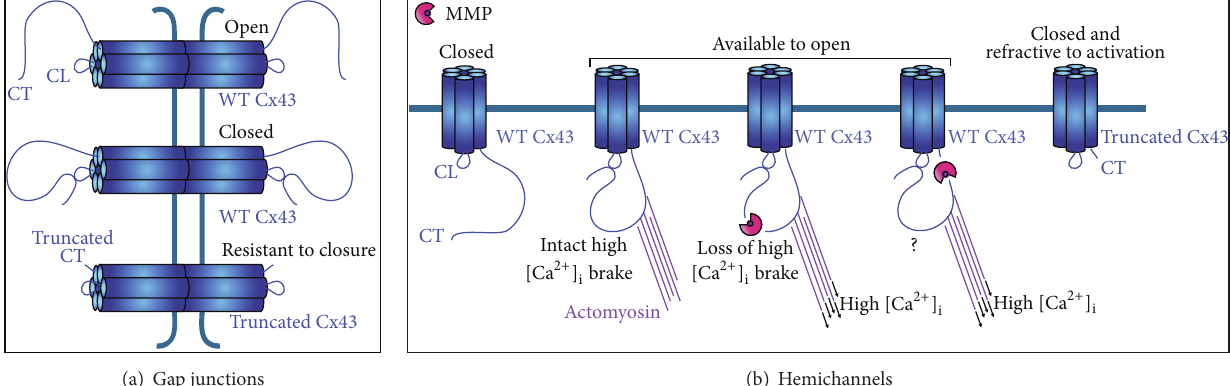
Figure 2: Cx43 channel gating by CT-CL interactions and possible effects of Cx43 C-terminal cleavage on hemichannel function. The Cx43 C-terminal domain is intricately involved in gating of both HCs and GJ channels. (a) In normal conditions, GJ channels are open, with the C-terminal domains not interacting with the CLs. GJ closure occurs when the CT binds the CL (ball-and-chain closure). In GJ channels composed of CT-truncated Cx43, closure via the ball-and-chain mechanism cannot occur and GJ channels remain open. (b) An intramolecular CT-CL interaction has been proposed to bring Cx43HCs in the “available to open” state whereas in the absence of such interaction, HCs remain closed. HC closure at above 500 nM [ Ca 2+ ] i is mediated by cytoskeletal contractions that dislocate the C-terminal domain fromtheCL and act as a brake on HC opening. Such CT-CLinteraction cannot take place in HCsconsisting of C-terminallytruncated Cx43, making them refractive for activation. MMP cleavage of Cx43HCs in the “available to open” state will result in a C-terminal peptide that is bound to the CL. This will cause loss of the high [ Ca 2+ ] i brake when the cleavage site is located downstream of the Cx43-actomyosin interaction site. When the MMP cleavage site is located N-terminally of this actomyosin linker domain, the outcome is less clear. In principle, actomyosincontractionmayremovetheCTpeptidefromtheCL,butaresidualinteractionoftheCLwithmoreupstreamsequencesmaykeep the HC in an “available to open” state. Identification of the actomyosin interaction domain within the Cx43 C-terminal domain responsible for mediating the high [ Ca 2+ ] i brake on HC opening will resolve these